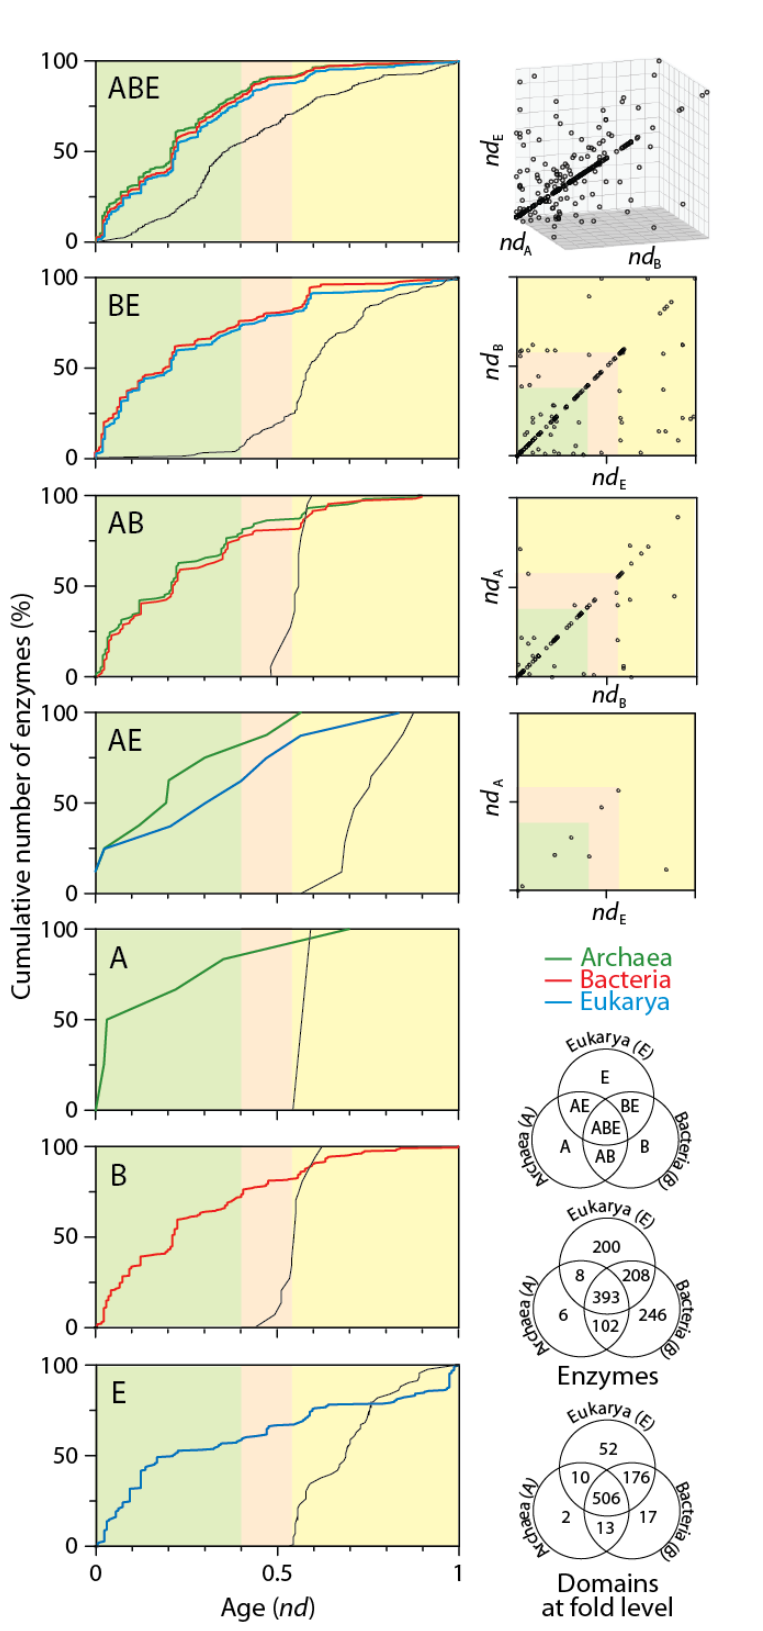
Figure 6: Timelines of enzyme evolution. Cumulative (left) and scatter (right) plots of ancestries are provided for each taxonomic group of enzymes described in the text. Reference curves in black show the accumulation of F domain structures for each taxonomic group. Venn diagrams describe the distribution of enzymes and domains in